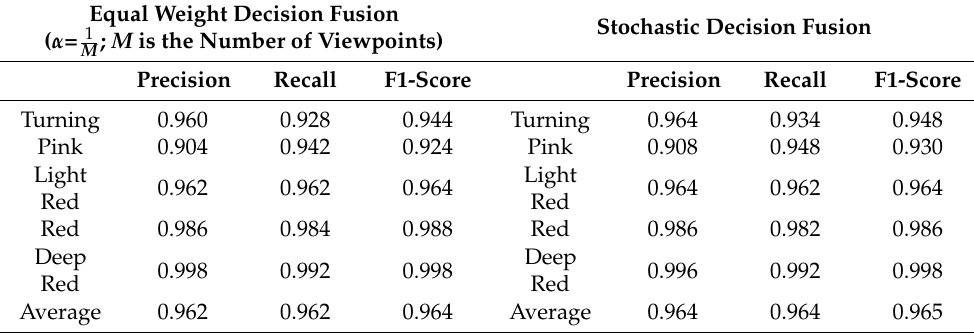
Table 4. Tomato ripeness detection performance reported by five-fold cross-validation based on two decision fusion methods: stochastic fusion versus equal-weighted fusion. Equal Weight Decision